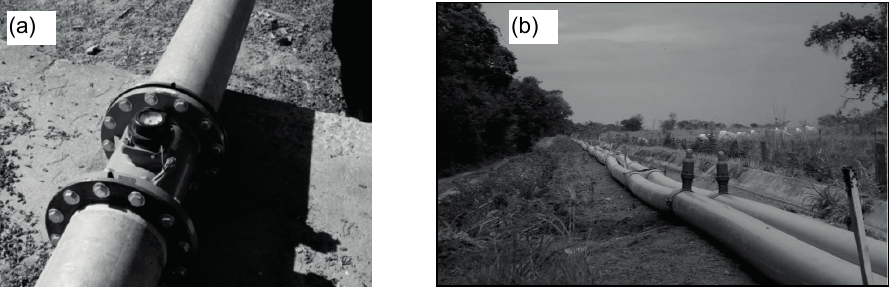
Fig. 4 Water meters for enforcement of restriction rules (a) and improvement of inefficient irrigation systems (b): open channel replaced by